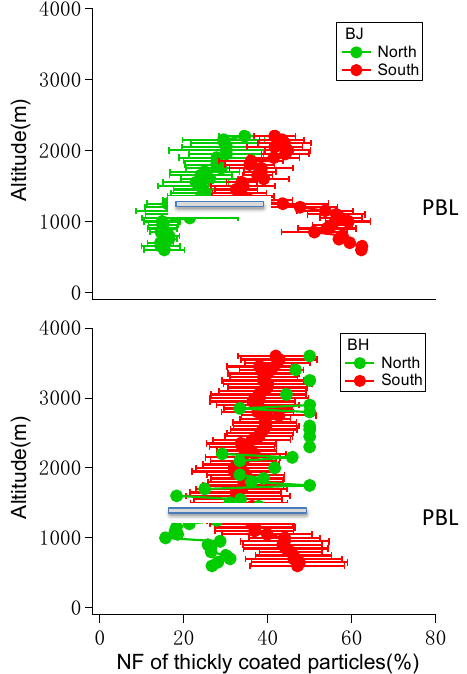
Figure 8. The measured vertical distributions of NF of the rBC particles from BJ and BH under different air masses. The red color represents the southern air mass, and the green color represents the northern air mass. The horizontal gray bars show the height of the PBL.